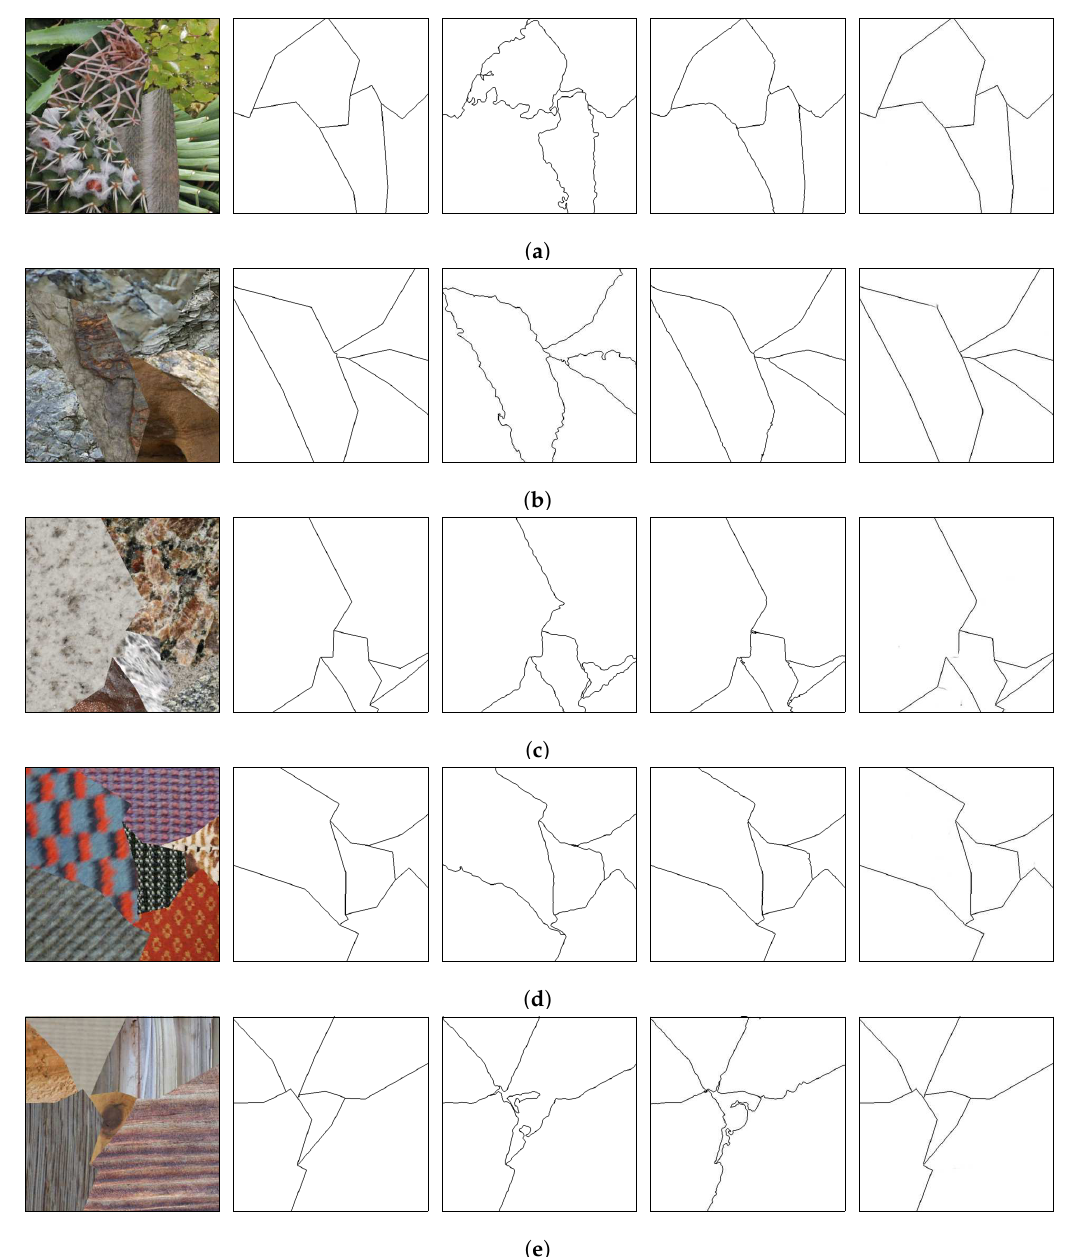
Figure 17. Comparison on the Prague Texture Dataset Generator and Benchmark [70]. From the first to the fifth column, respectively: original images; ground truths; edges produced by the network in [67]; edges produced by the network in [69]; edges produced in the presented method (continuation). Letters ( a – e ) present different benchmark textures mosaics and are used for referencing the images in the